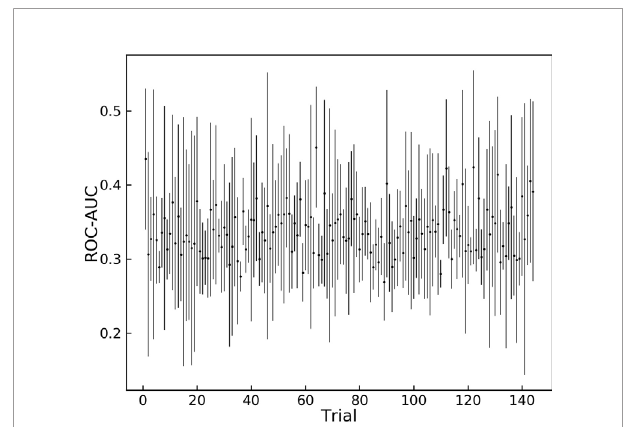
FIGURE 2 | Grid search results for different sets of hyper-parameters. 144 different sets of hyper parameters for the model are tested on the augmented validation